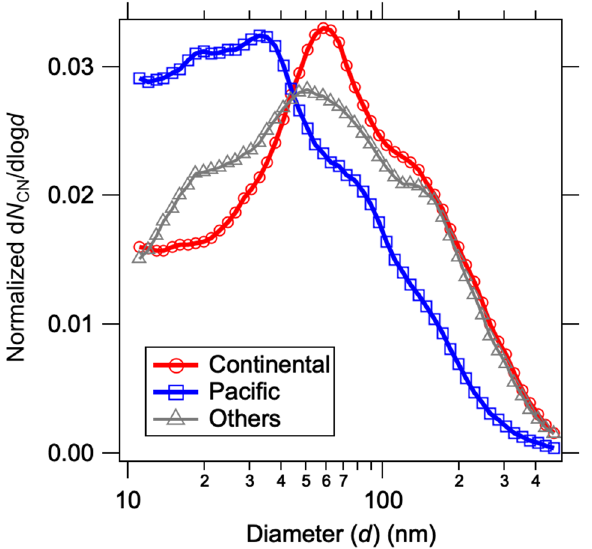
Figure 6. Normalized number size distribution of the aerosol particles at the MFRS classified according to air mass origins.